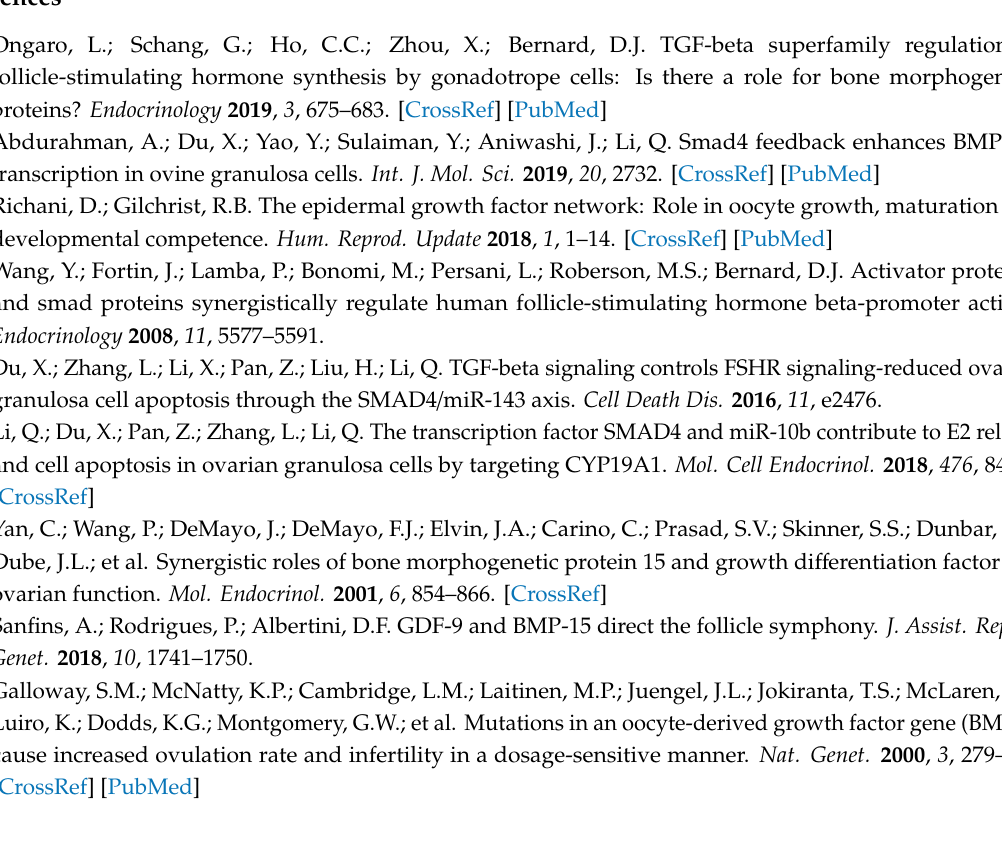
Supplementary Table S1: Statistical description of reproductive traits, Supplementary Table S2: Additive and dominant e ff ect of BMP7 on the reproductive traits in a Large White pig